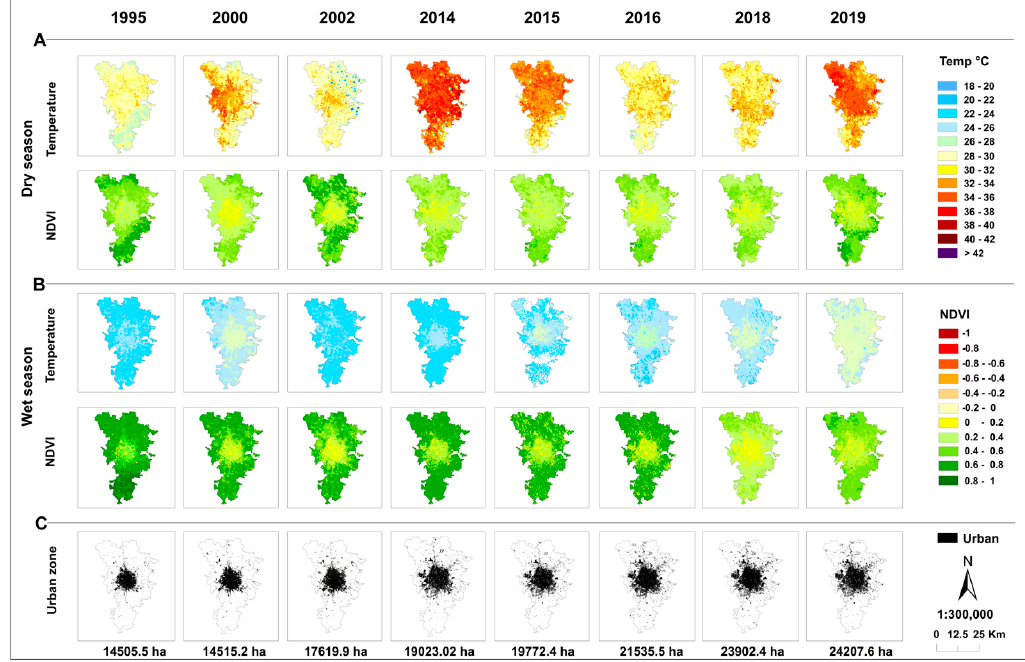
Table 5. Changes in Normalized Difference Vegetation Index (NDVI) and land surface temperature (LST) of the metro- politan city of Mérida.